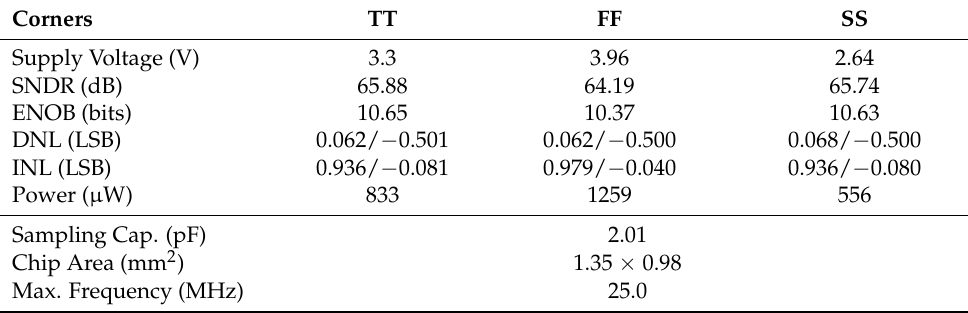
Figure 14. Chip microphotograph of the proposed SAR ADC. Table 4. Post-layout-simulated results of the proposed SAR ADC with three design corners. Corners